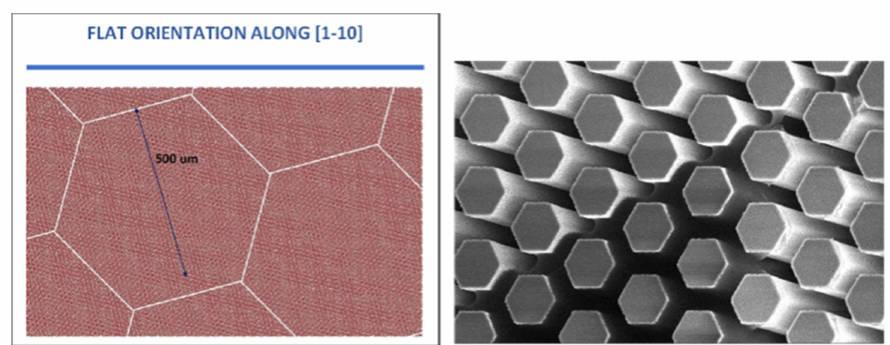
Figure 3. Pattern (left) and shape of the pillars (right). Both pillars and the pattern have a hexagonal structure.